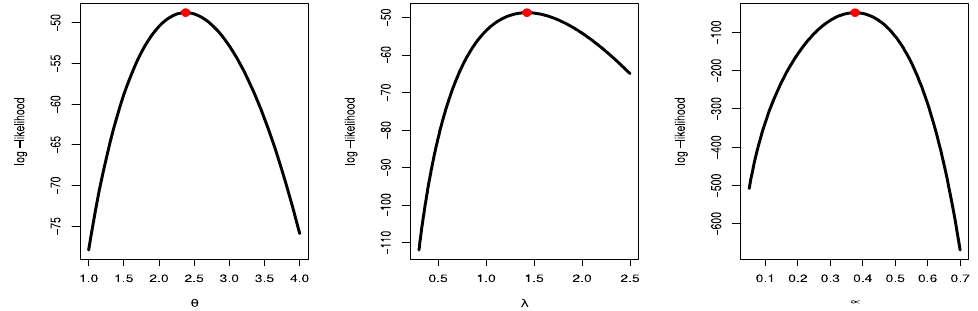
Figure 12. Likelihood profile for parameters of TCPWE distribution for strength data.